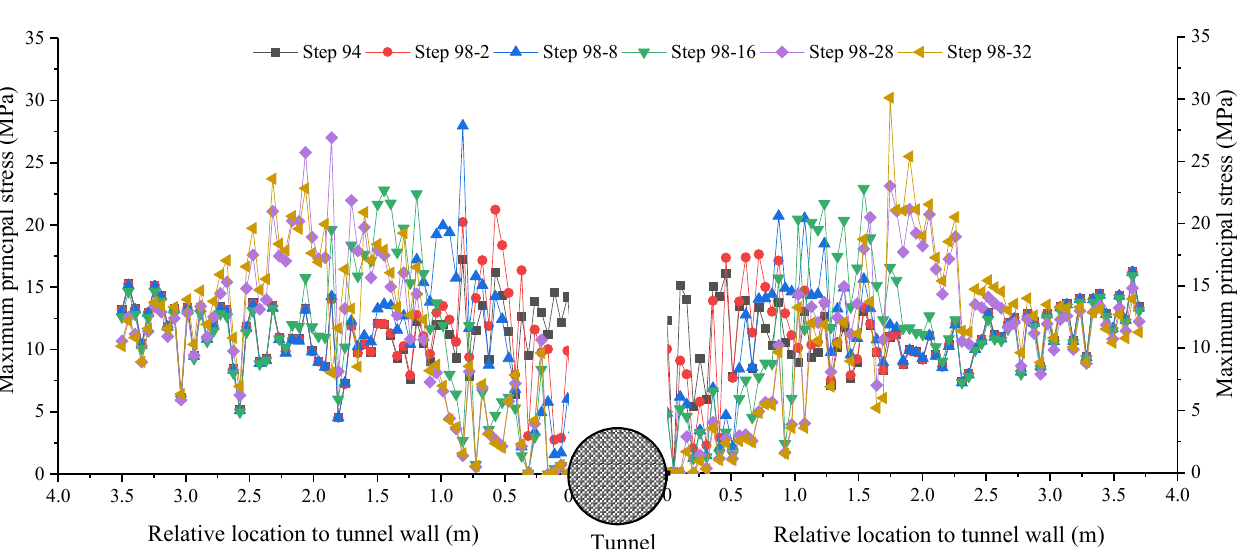
Figure 5. Distribution of elastic modulus during the zonal disintegration process of heterogeneous model around a circular tunnel: ( a ) Step 94; ( b ) Step 98-2; ( c ) Step 98-8; ( d ) Step 98-16; ( e ) Step 98-28; ( f ) Step 98-32.